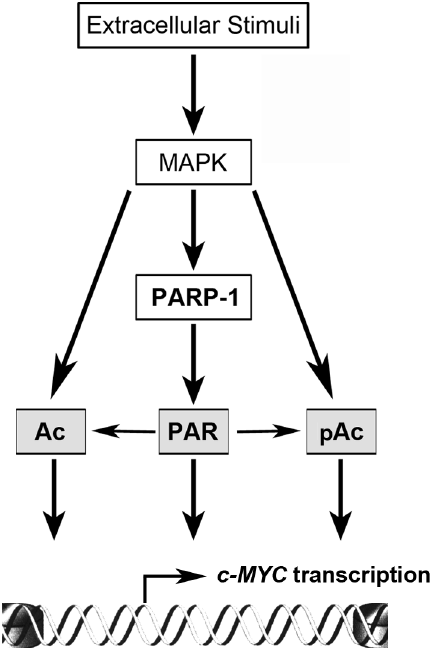
Figure 7. Schematic model of the functional relationship between poly(ADP-ribosyl)ation and histone modifications at c-MYC promoter. Ac: Acetylation; PAR: Poly(ADP-ribosyl)ation; pAC: Phosphoacetylation.